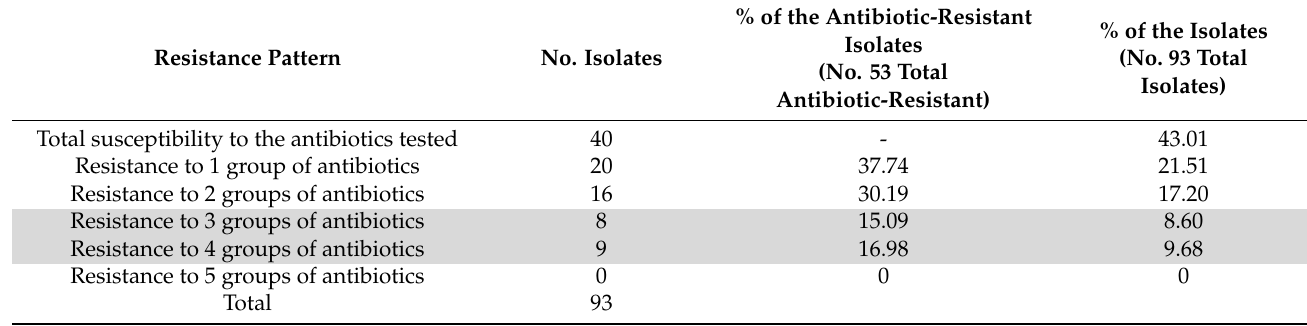
Table 3. Percentage of P. aeruginosa isolates resistant to 1, 2, 3, 4, 5 groups of antibiotics tested.